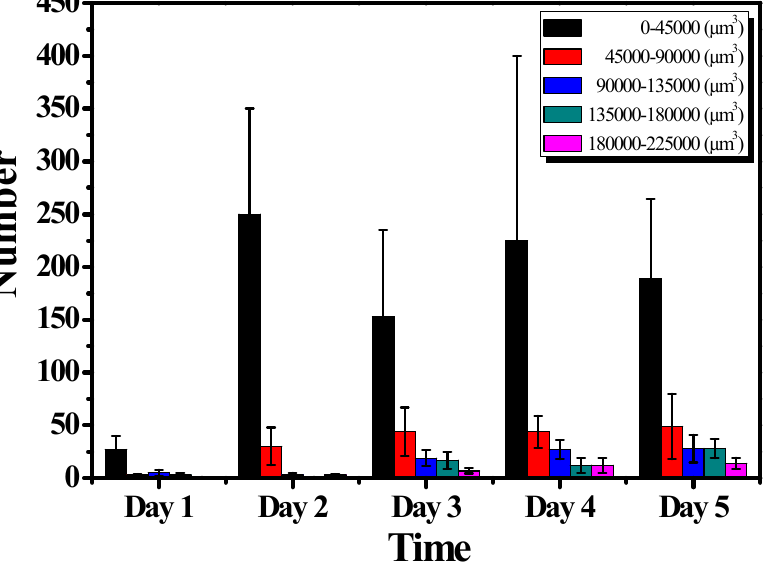
Figure 8. Distribution of cell colony volume during a 5-day culture course. The data were generated from at least three repeated experiments. The error bars represent the standard deviations.